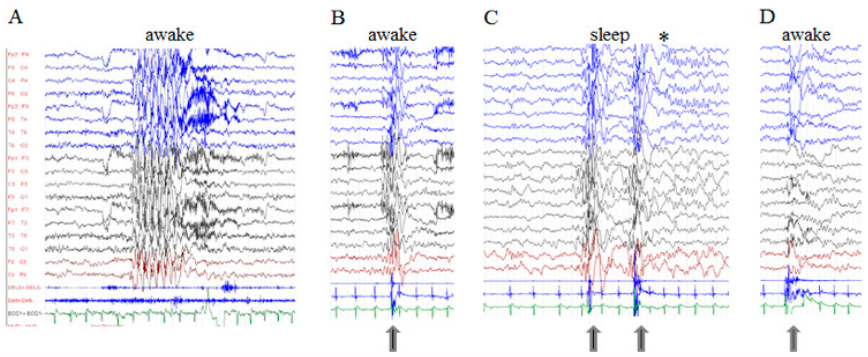
Figure 2. Group 2: Ictal EEG in a 9-year-old girl (Pt16, Trp531Cys). ( A ) Subclinical discharge of diffuse and irregular SW. ( B ) Bursts of diffuse polyspike and polyspike-waves, with anticipated onset over the frontal or posterior areas, accompanied by myoclonic jerks of both arms (arrows) while awake. ( C ) The same polyspike and polyspike-waves recorded during sleep. Note the spindles on the fronto-central regions (*). ( D ) Muscle artifacts associated to a startle response without paroxysmal abnormalities.